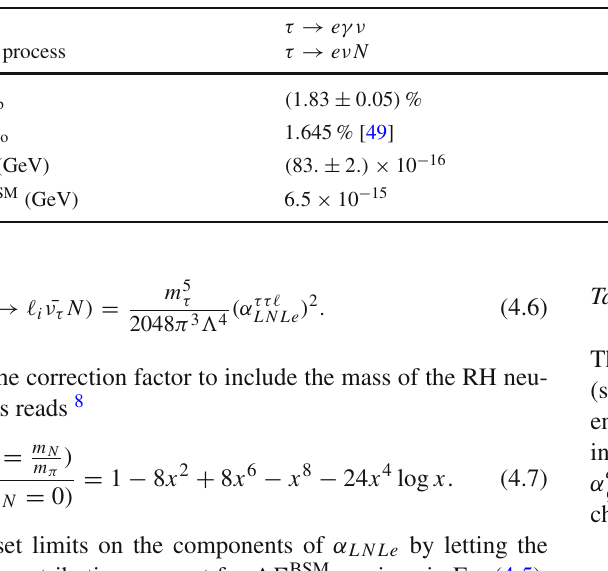
Table 6 Measured values and theoretical predictions of branching ratios for different τ decays. All experimental values are taken from the PDG [34]. For convenience, we also translate the measured branch-